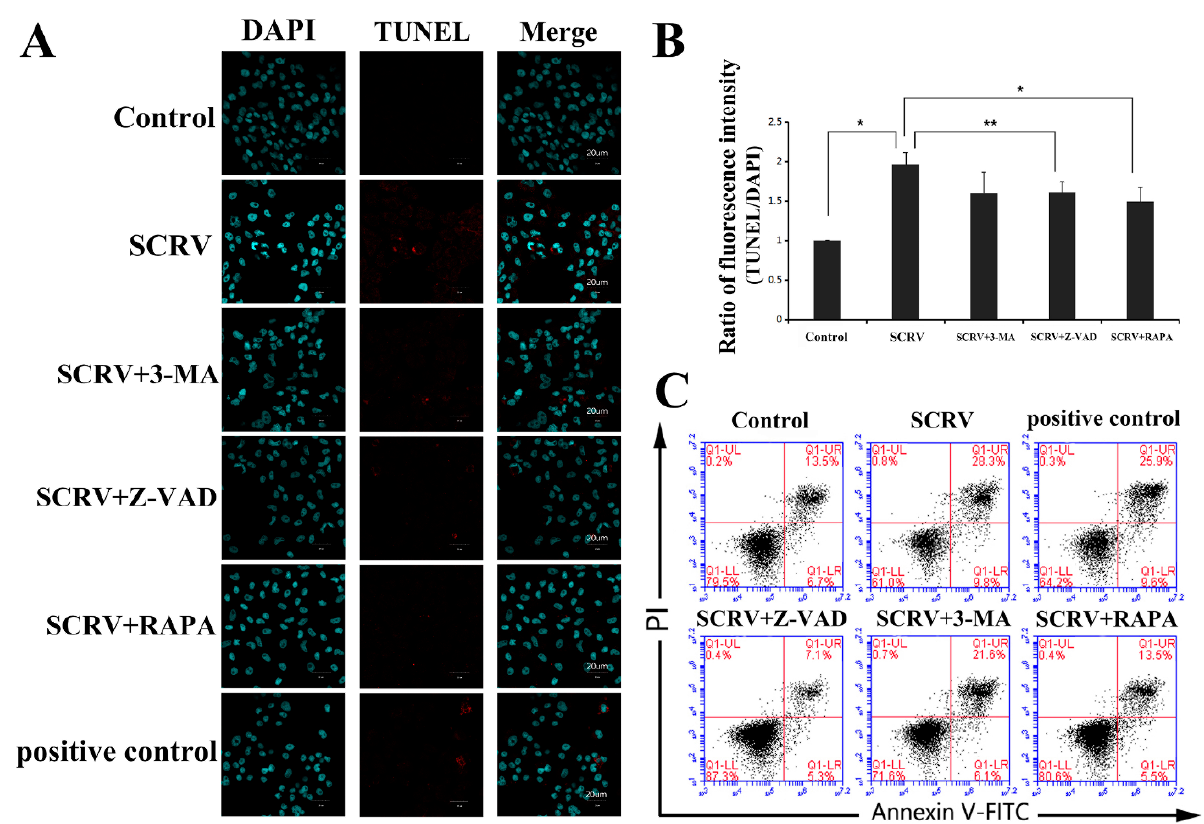
Figure 2. Detection of the effects of different chemical treatments on apoptosis in SCRV-infected EPC cells. ( A ) Immunofluorescence analysis of SCRV-infected cells after DAPI and TUNEL staining at 24 h. The infected cells were co-treated with Z-VAD-FMK (100 μ M), 3-MA (5 mM) and rapamycin (1 μ M, abbreviated RAPA), respectively. The nuclei were stained with DAPI (blue). The nuclei of apoptotic cells are stained with TUNEL (red). ( B ) Statistical analysis of fluorescence intensity of TUNEL/DAPI. Rapamycin could reduce the value of intensity statistically. p < 0.05 (*), p < 0.01 (**). ( C ) Flow cytometry analysis of SCRV-infected cells after AV-PI double staining at 24 h. Rapamycin could also reduce the percentage of apoptotic cells.